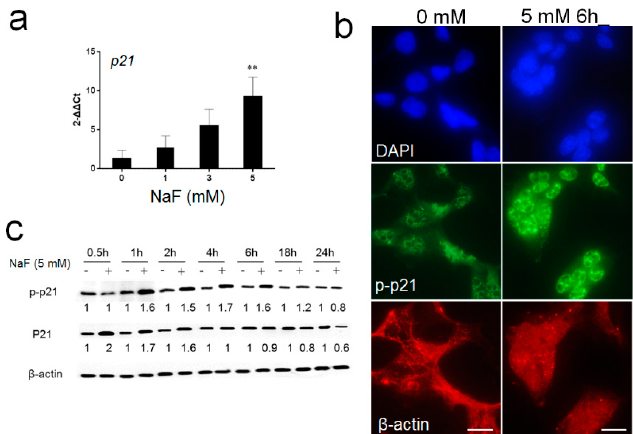
Figure 1. Fluoride upregulates p21 mRNA and p21/p-p21 protein in LS8 cells. ( a ) LS 8 cells were treated with NaF at the indicated concentrations for 24 h and p21 mRNA was then quantified by quantitative polymerase chain reaction (qPCR). Fluoride (5 mM) treatment significantly increased p21 mRNA levels. Gapdh was the internal reference control gene. Data are presented as means ± standard deviation (SD) (** p < 0.01 vs. 0 mM). ( b ) Cells were treated with NaF (5 mM) for 6 h and phospo-p21 (p-p21; green), nucleus (4',6-diamidino-2-phenylindole (DAPI); blue) and β -actin (red) were detected by immunocytochemistry. Fluoride increased p-p21 protein levels in LS8 cells. ( c ) LS8 cells were treated with NaF (5 mM) for the indicated times and p21 (18 kDa) and p-p21 (21 kDa) were detected by Western blots. Fluoride increased p21 and p-p21 protein expression in the early phase (1 to 6 h), control β -actin (44 kDa). Statistical analysis of relative protein expression of p21 and p-p21 are shown